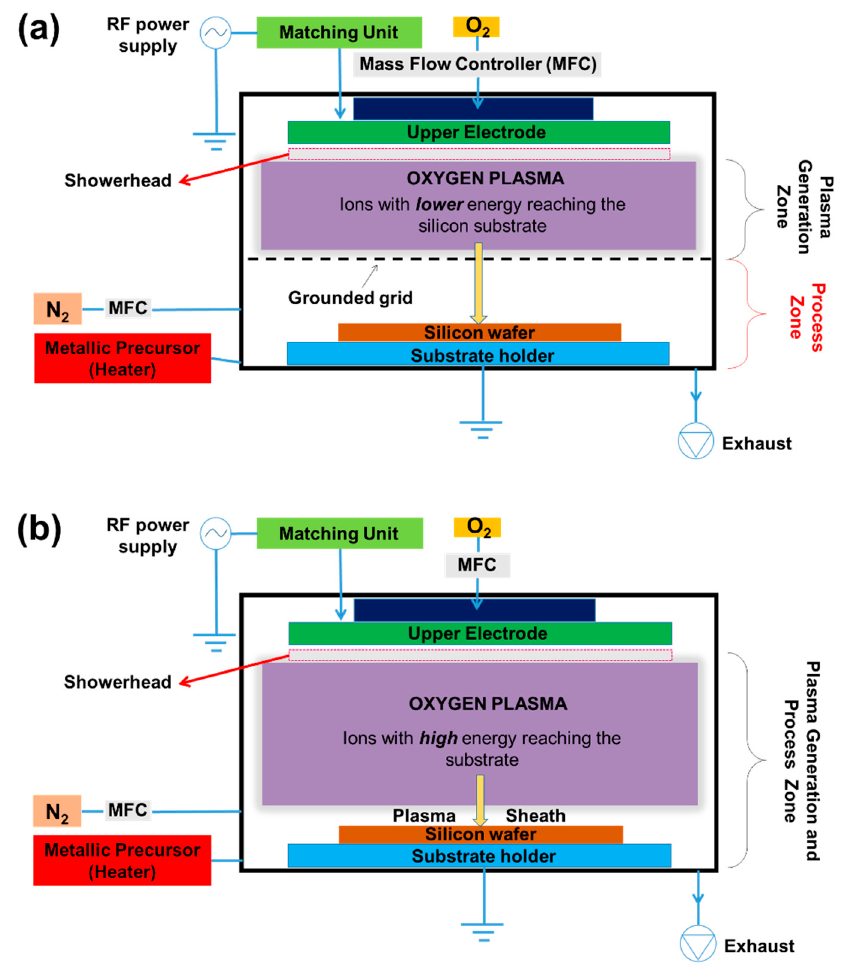
Figure 1. Schematic diagram of the capacitively coupled plasma reactor used for plasma-enhanced atomic layer deposition (PEALD) processes: ( a ) remote plasma mode and ( b ) direct plasma